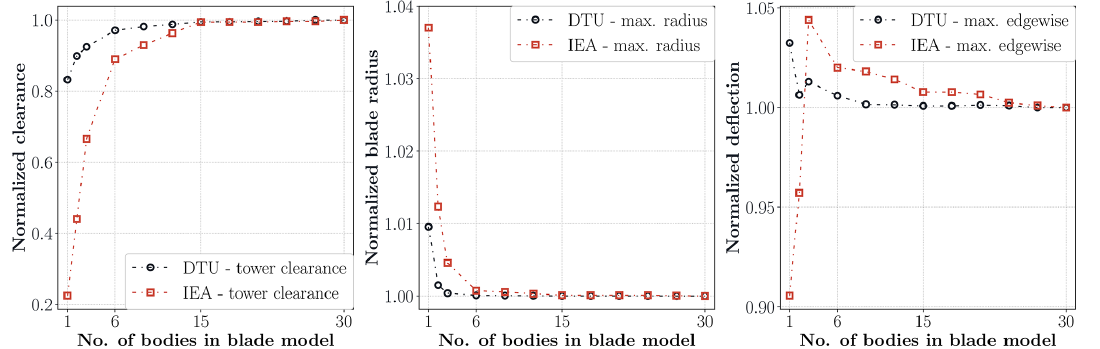
Figure 5. Normalized blade tip minimum tower clearance, maximum effective blade radius and blade edgewise deflection results. Values are normalized with respect to the results of the 30-sub-body case.